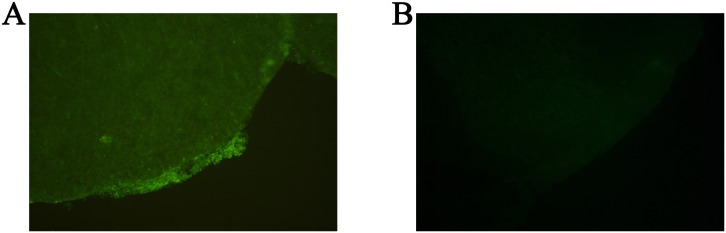
Enhanced green fluorescence protein (EGFP) expression in the meningeal pia mater cells.EGFP expression was located in the meningeal pia mater cells in the Ad-EGFP group after intrathecal injection (see red arrow in the panel A), suggesting that adenovirus was transfected into the same location. This was not observed in the normal saline group as indicated in panel B.